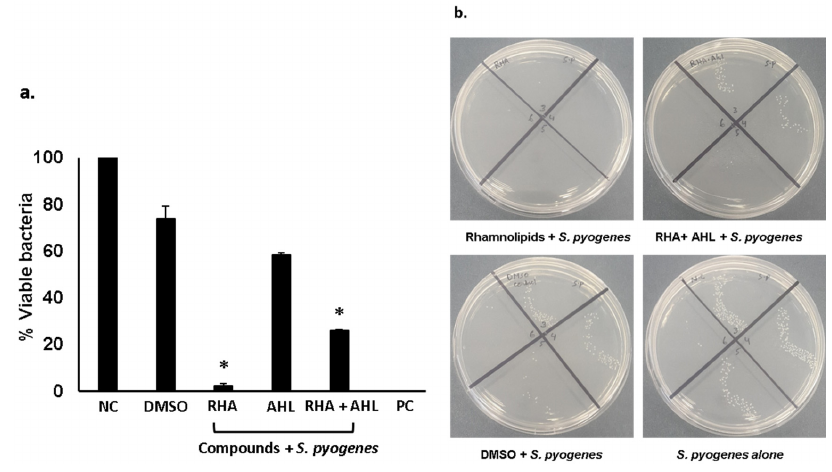
Figure 3. Antibacterial assays of pure compounds against S. pyogenes. Briefly, 1 × 10 6 bacteria were incubated with pure compounds at 50 µg/mL for 2 h at 37 °C. Next, cultures were diluted, plated onto agar plates and plates were incubated overnight at 37°C. Following this incubation, bacterial c.f.u was determined by counting viable colonies. ( a ) bactericidal and ( b ) bacteriostatic activities of rhamnolipids and N -acyl homoserine lactones against S. pyogenes. P -values were determined by student’s T-test where (*) represents P < 0.05 using GraphPad Prism 8.0.2. The data are expressed as the mean ± SE of several independent experiments performed in duplicate.